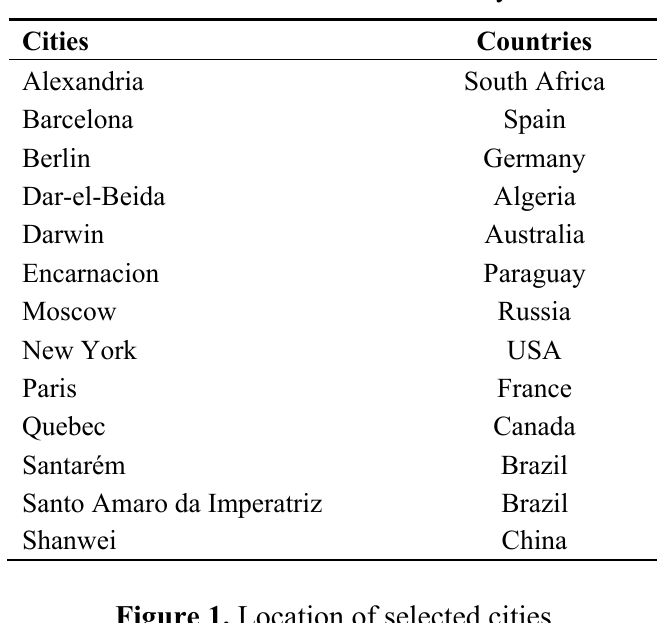
Table 1. Cities chosen for analysis.